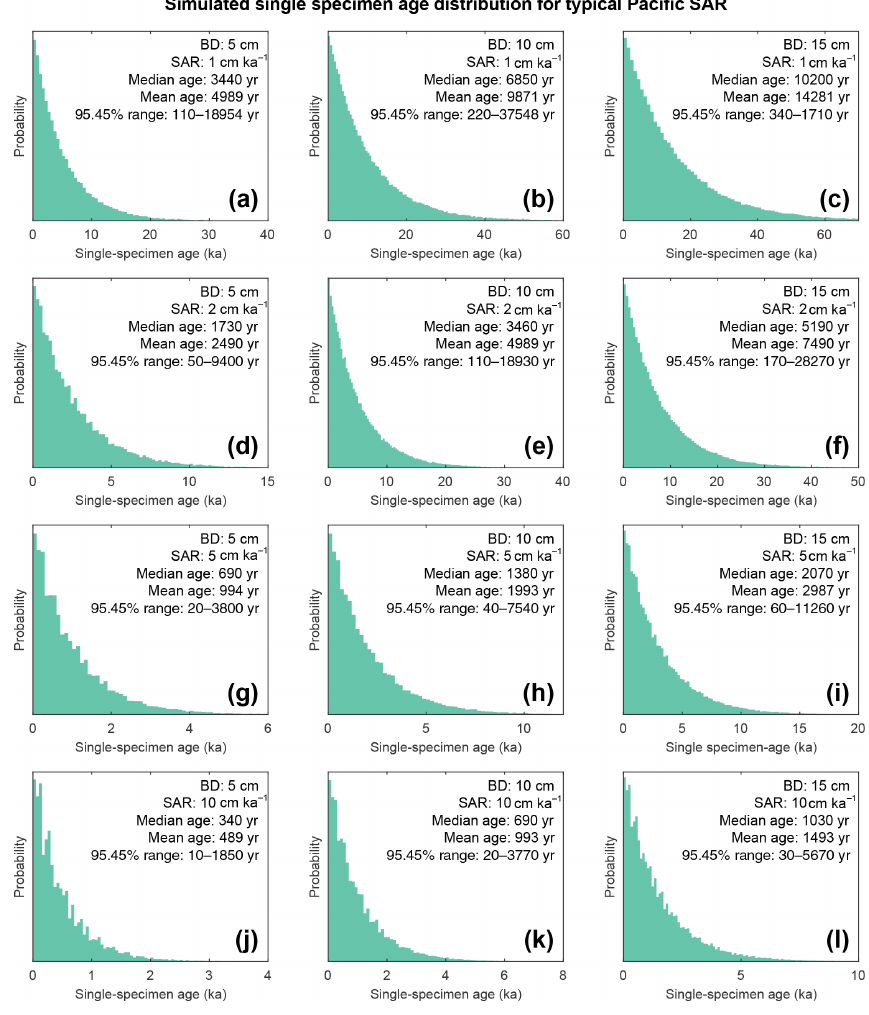
Figure 9. Histograms of simulated specimen age within the bioturbation depth. The simulated age distribution present within the sediment mixed layer, referred to here as bioturbation depth (BD). BD is fixed at (a, d, g, j) 5cm, (b, e, h, k) 10cm, and (c, f, i, l) 15cm for sedimentation accumulation rates (SAR) of (a–c) 1cmkyr − 1 , (d–f) 2cmkyr − 1 , (g–i) 5cmkyr − 1 , and (j–l) 10cmkyr − 1 . The output is plotted as the discrete 1cm depth median age. Note the size of the BD varies; therefore the simulated age distribution comes from a varying core